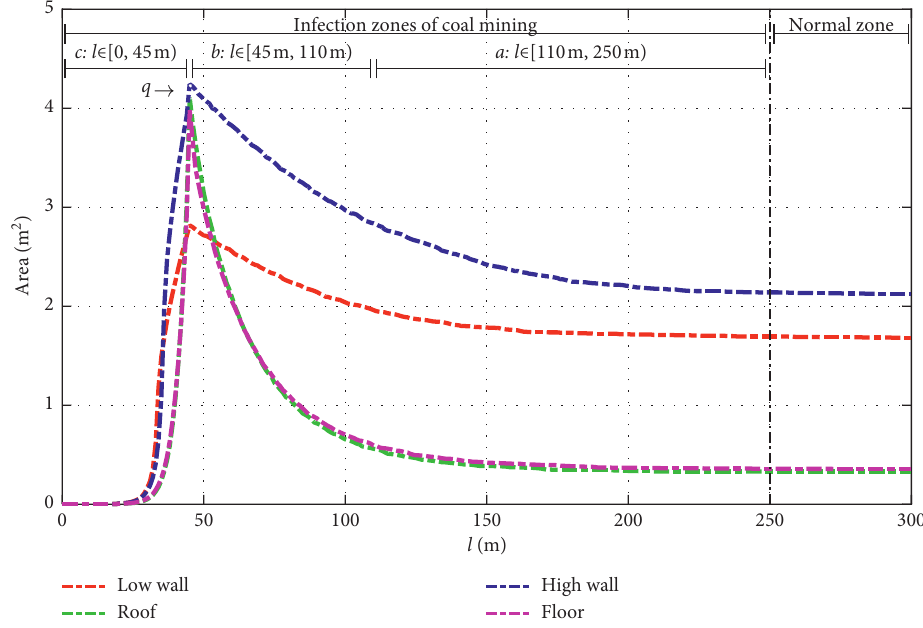
Figure 8: The curve of the AUA of the two sides and the roof and floor upon